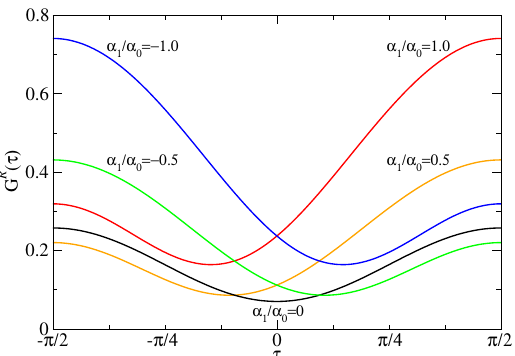
Figure 5 . We depict here the boundary shapes given by G R ( (cid:11) 0 ; (cid:11) 1 ) of the Penrose diagram of the spacetime with the linear combination of h 0 and h 1 . We set (cid:11) 0 = 1 in the (cid:12)gure. The shape of the left side is given by the relation G L ( (cid:11) 0 ; (cid:11) 1 ) = G R ( (cid:11) 0 ; (cid:0) (cid:11) 1